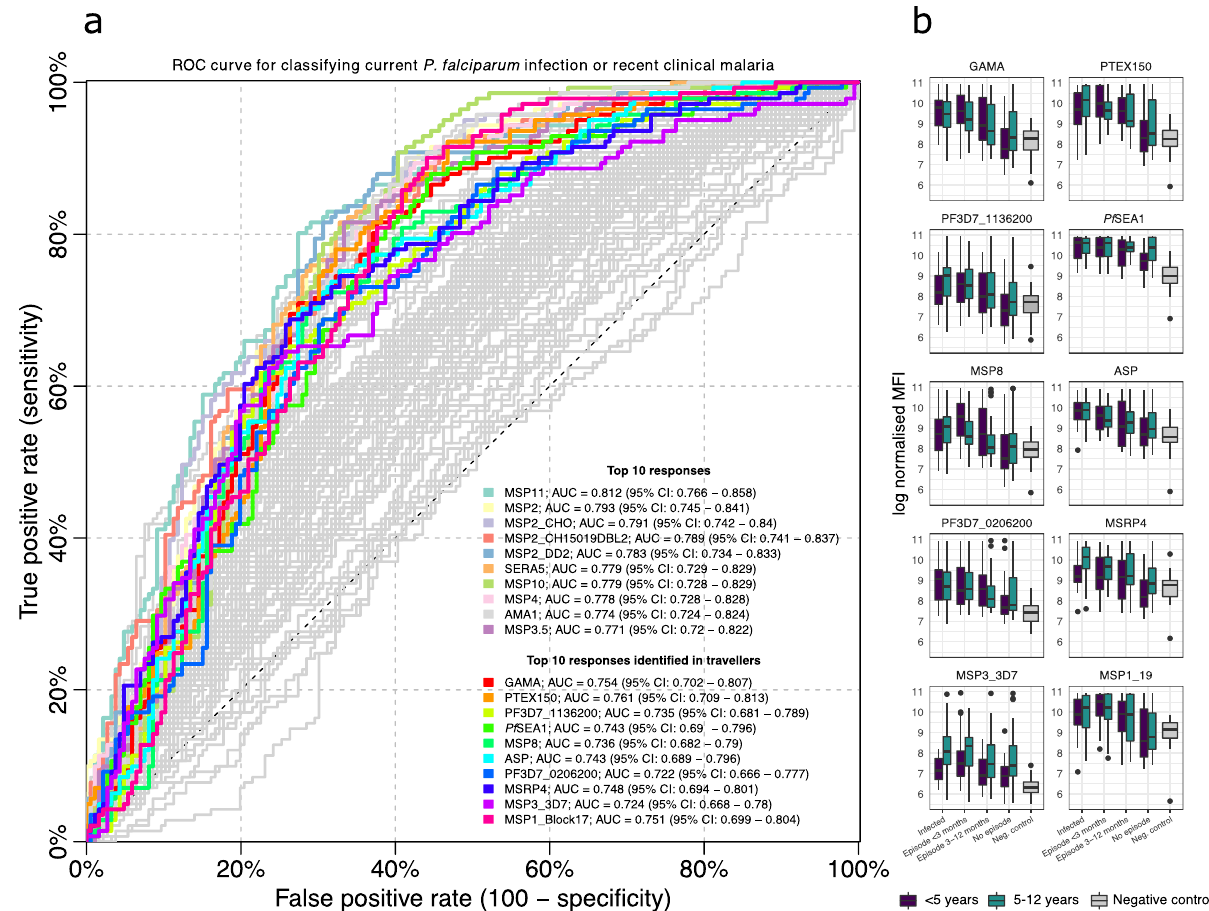
Fig. 9 Identifying recent infection in Kenyan children. a Receiver operating characteristic (ROC) curve for classifying individuals as currently infected or having suffered from a clinical malaria episode within 90 days using a threshold antibody level to a single antigen. The fi rst set of coloured curves correspond to the top 10 antibody responses that were most informative as determined by the classi fi er area under the ROC curve (AUC). The second set of coloured curves indicates the performance of antibody responses identi fi ed as individually most informative in detecting recent P. falciparum exposure within the longitudinally monitored travellers cohort. b Box-plots of the magnitude of the antibody response in Junju children age <5 years (dark blue, 114 samples ( s ) from 114 unique study participants ( n )) and age 5 – 12 years (green, s = 166, n = 166) relative to current infection status and time since last documented clinical malaria episode as well as the reactivity in negative controls (light grey, s = 42, n = 42) for antibody responses identi fi ed as individually most informative in detecting recent P. falciparum exposure within the longitudinally monitored travellers cohort. The centres of boxes correspond to the median. The lower and upper hinges of boxes correspond to the fi rst and third quartiles of the data. The upper and lower whiskers extend from the hinges to the largest and smallest values, respectively, no further than 1.5 * the interquartile range from the hinges. Data beyond the end of the whiskers are plotted